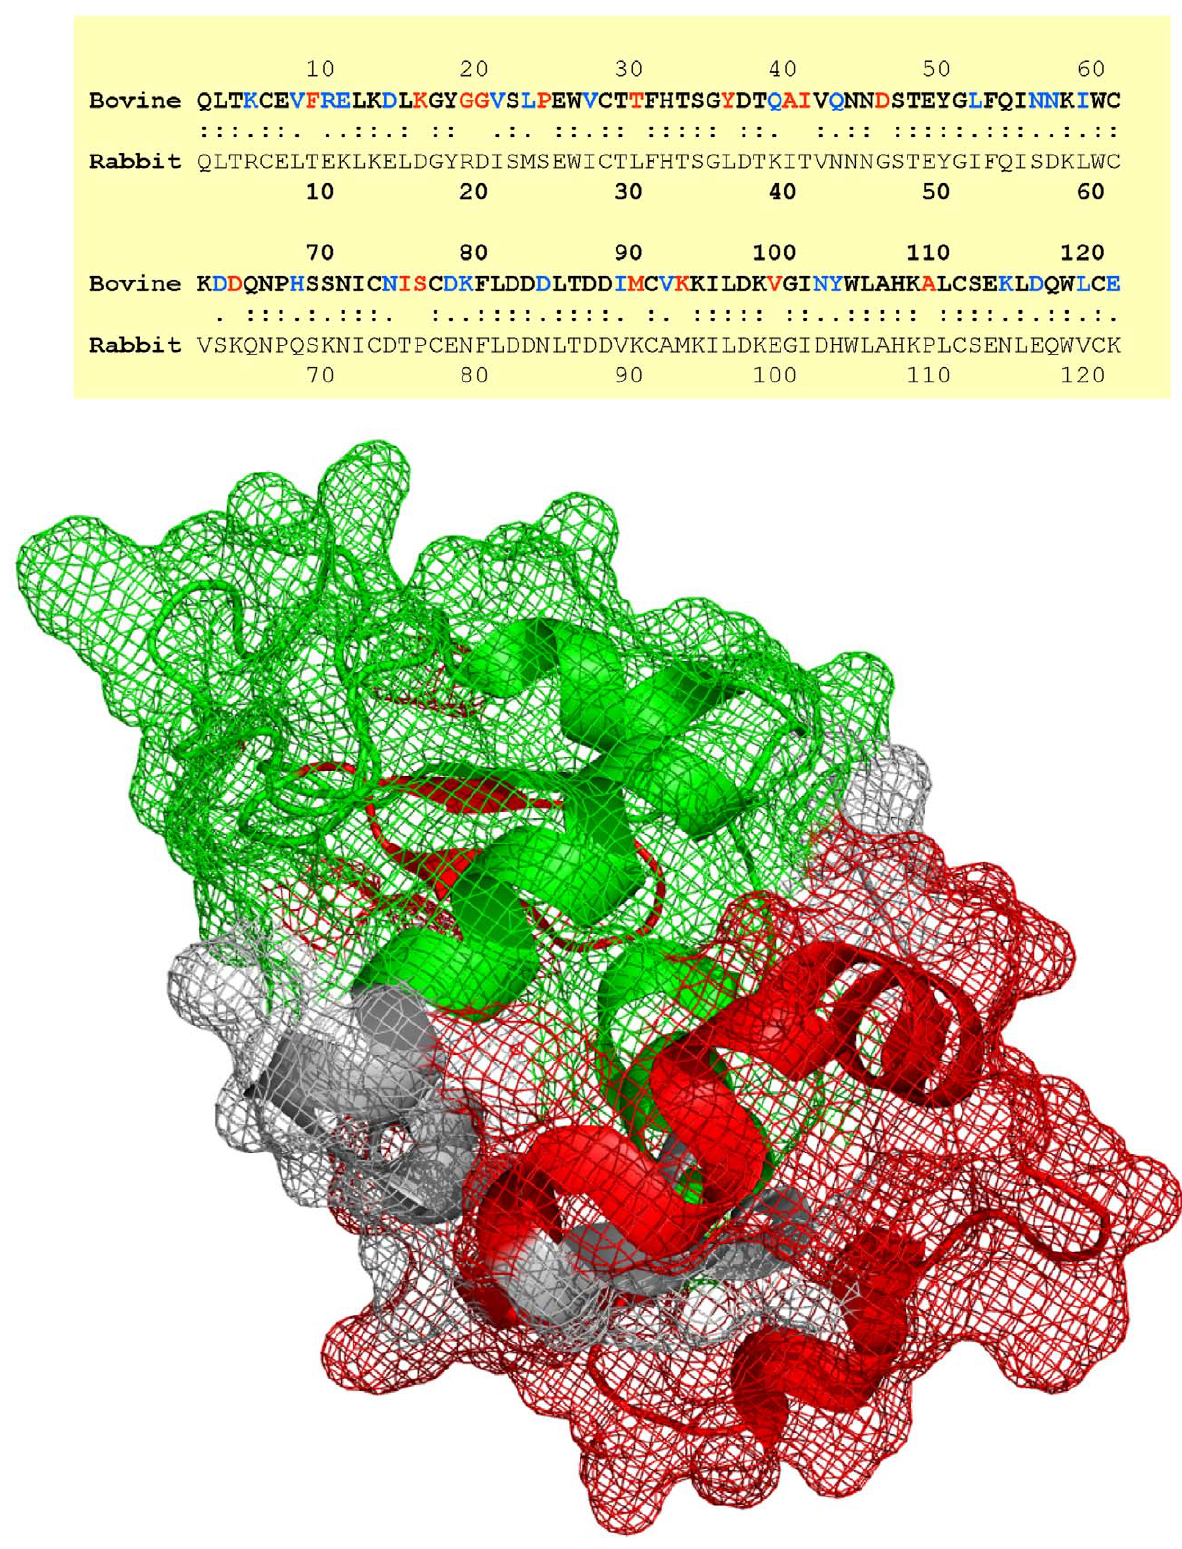
Figure 7. Mapping of immunoreactive linear epitopes of bovine a -lactalbumin to its primary sequence and crystal structure. Top: Sequence homology between bovine and rabbit a -lactalbumin. Conservative and non-conservative changes are shown in blue and red, respectively. Bottom: Mapping of immunoreactive linear epitopes to the crystal structure of bovine a -lactalbumin (PDB code: 1F6R). Regions colored green show contiguous immunodominant epitopes elicited by both 4 and 8 , while regions colored red show additional epitopes specifically adjuvanted by 8 .